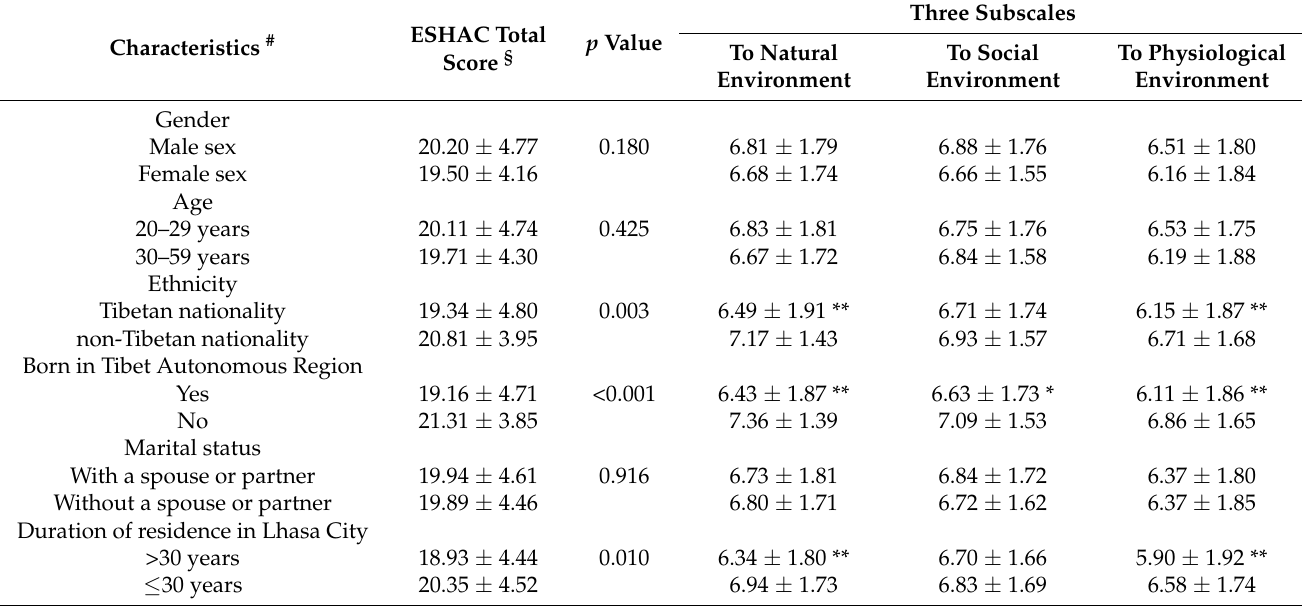
Table 4. Social fitness: the results of the Evaluation Scale of Human Adaptation Capability